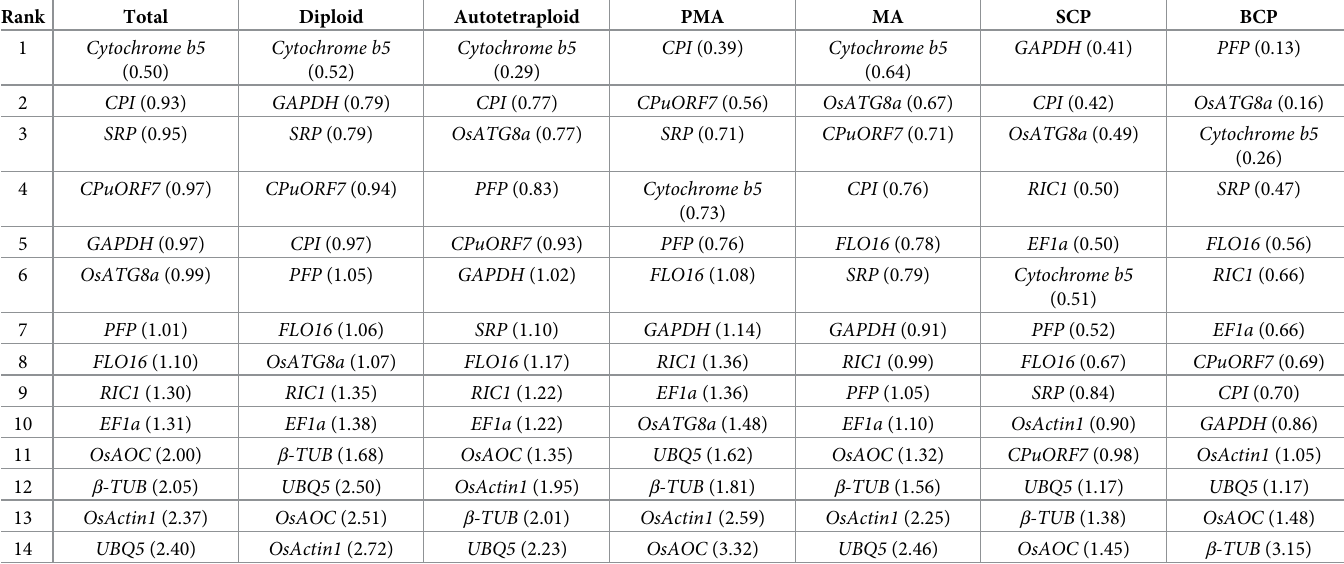
Table 3. Stability analysis of candidate reference genes assayed by NormFinder